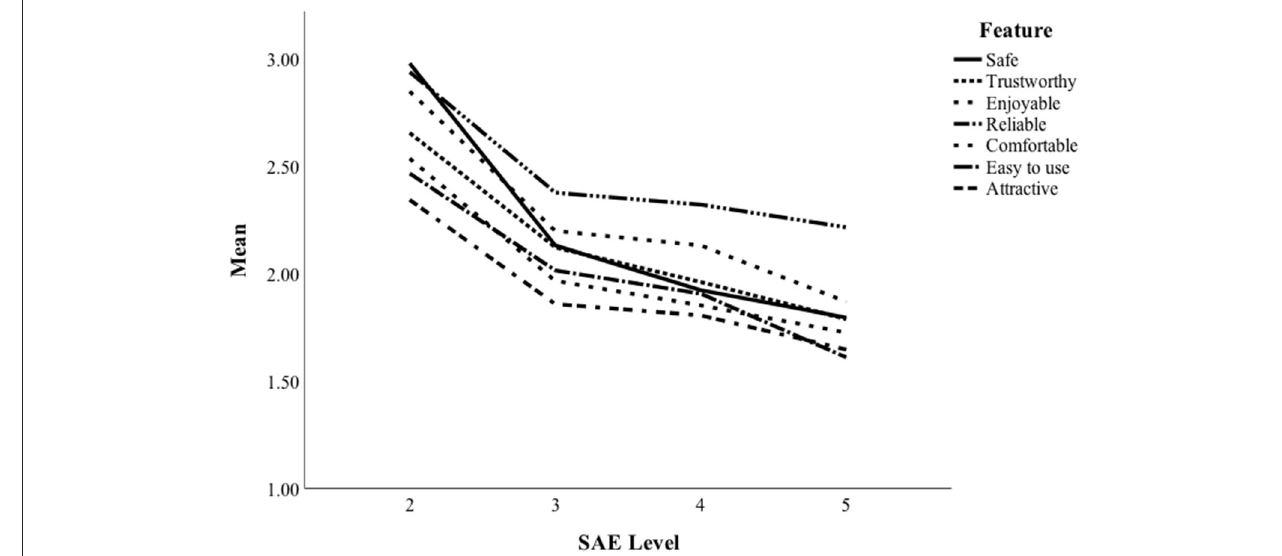
FIGURE 1 | Attitudes to vehicles (SAE levels